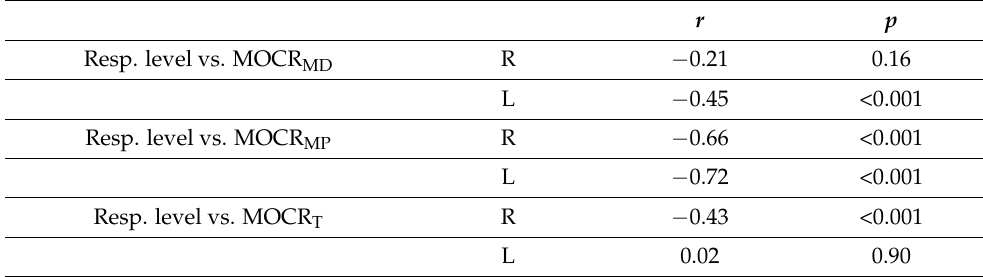
Table 4. Correlations between response level and MOCR estimates. R, right; L, left.